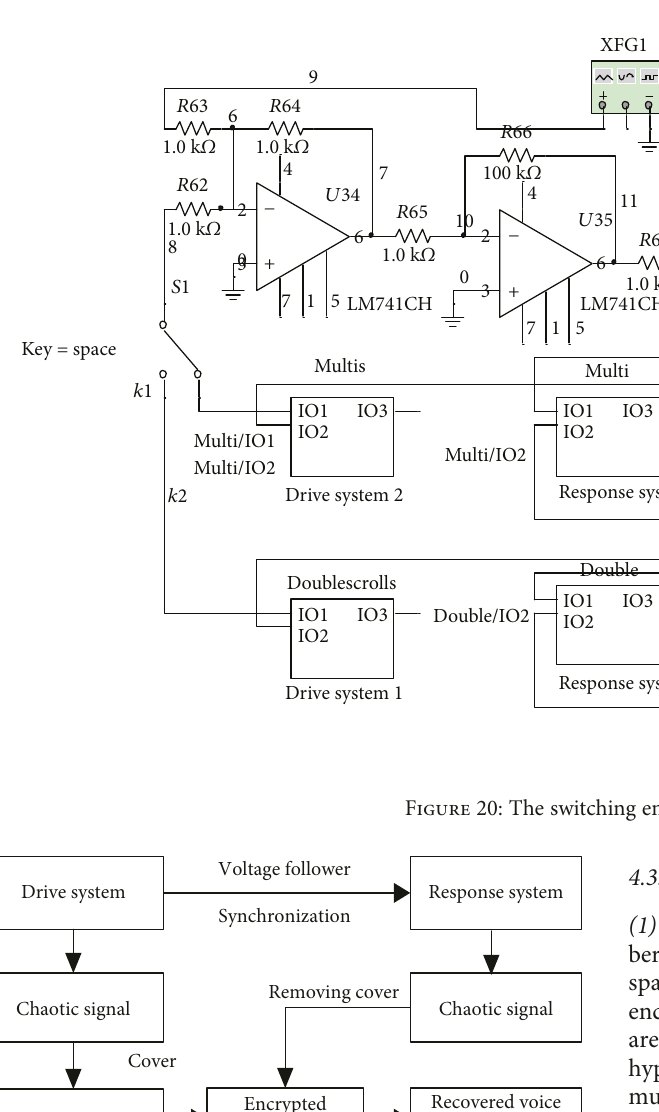
Figure 21: Encryption and decryption fl ow